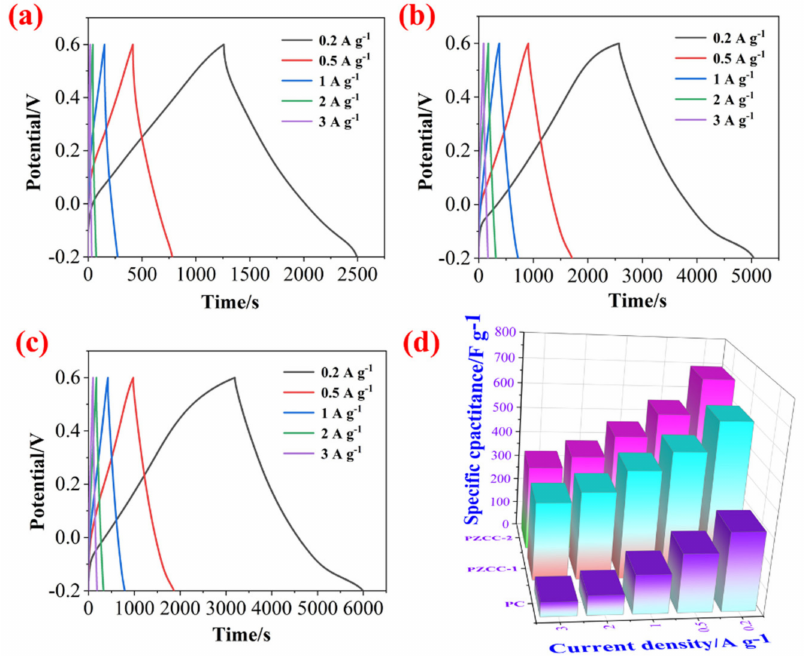
Figure 6. GCD profiles of PC ( a ), PZCC-1 ( b ), and PZCC-2 ( c ) electrodes at different current densities of 0.2, 0.5, 1, 2, and 3 A · g − 1 . ( d ) Comparative profiles of specific capacitance for PC, PZCC-1, and PZCC-2.